Question: Express in one sentence what the figure is showing.
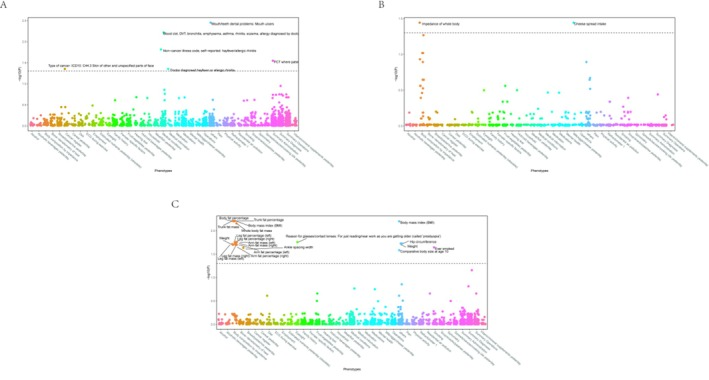
Answer: Results of phenome‐wide MR of 3 plasma proteins. (A) Manhattan plot of phenome‐wide MR results for (TNFSF8) CD30 ligand. The horizontal coordinates represent the categories for each phenotype. The dotted black line in the figure indicates the threshold for an FDR‐ p value < 0.05. When a phenotype's measure exceeds this line, it is considered significant, indicating the presence of the corresponding side effect. (B) Manhattan plot of phenome‐wide MR results for (HSD17B14) DHB14. The horizontal coordinates represent the categories for each phenotype. The dotted black line in the figure indicates the threshold for an FDR‐ p value < 0.05. When a phenotype's measure exceeds this line, it is considered significant, indicating the presence of the corresponding side effect. (C) Manhattan plot of phenome‐wide MR results for (XXYLT1) XXLT1. The horizontal coordinates represent the categories for each phenotype. The dotted black line in the figure indicates the threshold for an FDR‐ p value < 0.05. When a phenotype's measure exceeds this line, it is considered significant, indicating the presence of the corresponding side effect.